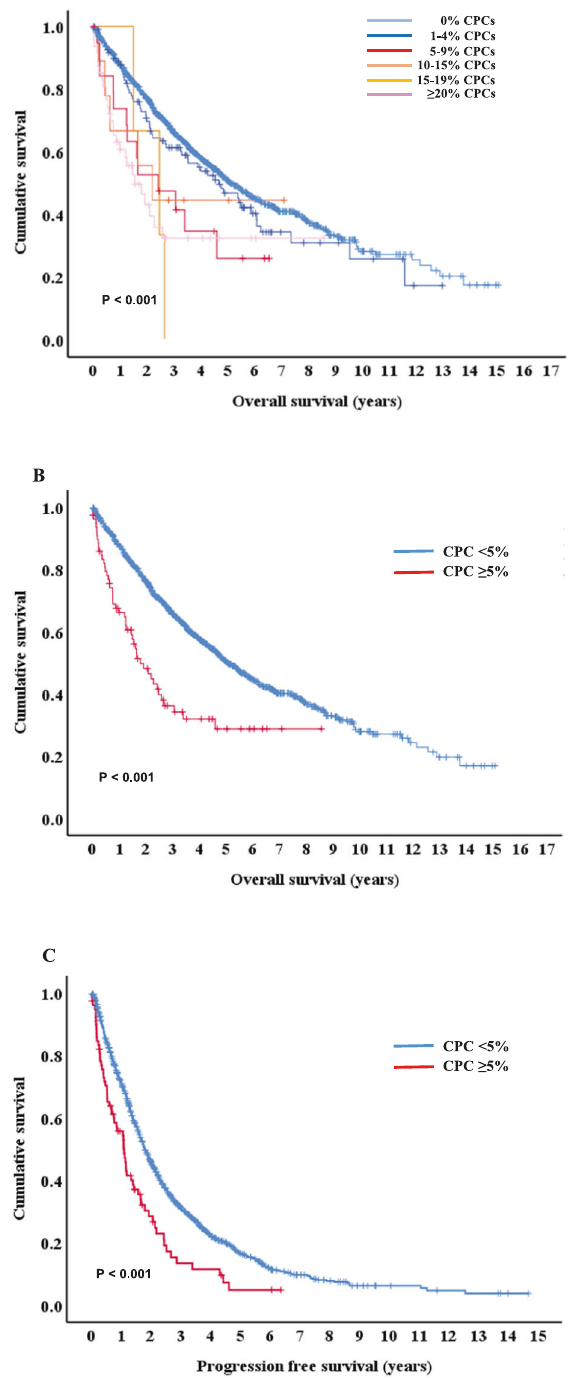
Fig. 1 Survival outcomes by the percentage of circulating plasma cells. Kaplan-Meier survival curves for overall survival (OS) based on the percentage of circulating plasma cells (CPCs) ( A ), OS for patients with CPCs ≥ 5% ( B ), and progression free survival for patients with CPCs ≥ 5% (C). (R-ISS) and Second Revision of the International Staging System (R2-ISS) were used to stage the disease at the time of diagnosis [8, 9]. Response to induction therapy was assessed using the IMWG uniform response criteria [10]. Patients with t(4;14), t(14;16), or del(17p) detected using fl uorescence in situ hybridization (FISH) were classi fi ed as high cytogenetic risk.